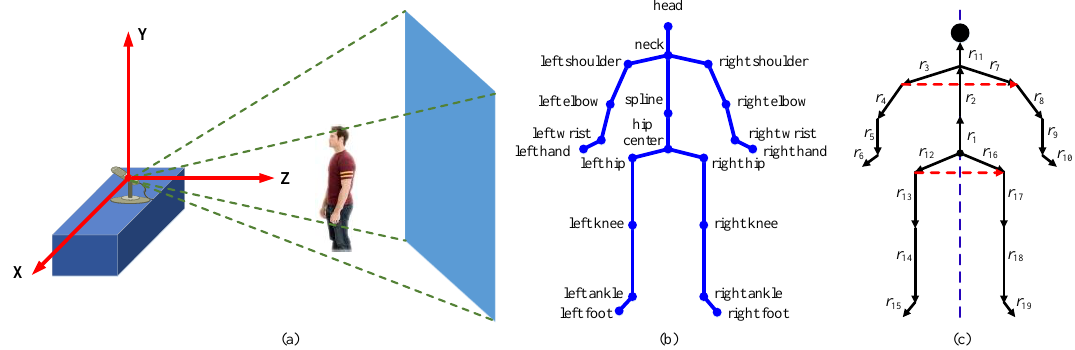
Figure 1. Skeleton and preprocessing. ( a ) World coordinate system of the Kinect. ( b ) Twenty joints provided by the evaluation datasets. ( c ) Nineteen limb lengths represented by r i ( i = 1, 2, ..., 19). The two vectors indicated by the red dashed arrows are constructed for viewpoint calibration. The blue dashed line indicates the symmetry of the human body.